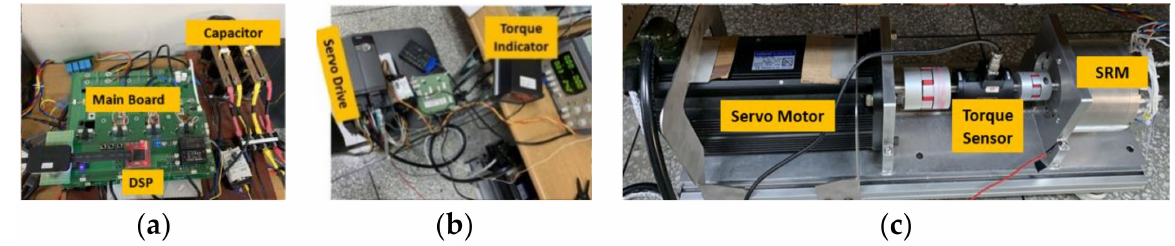
Figure 15. Test set-up: ( a ) Controller, ( b , c ) Measurement